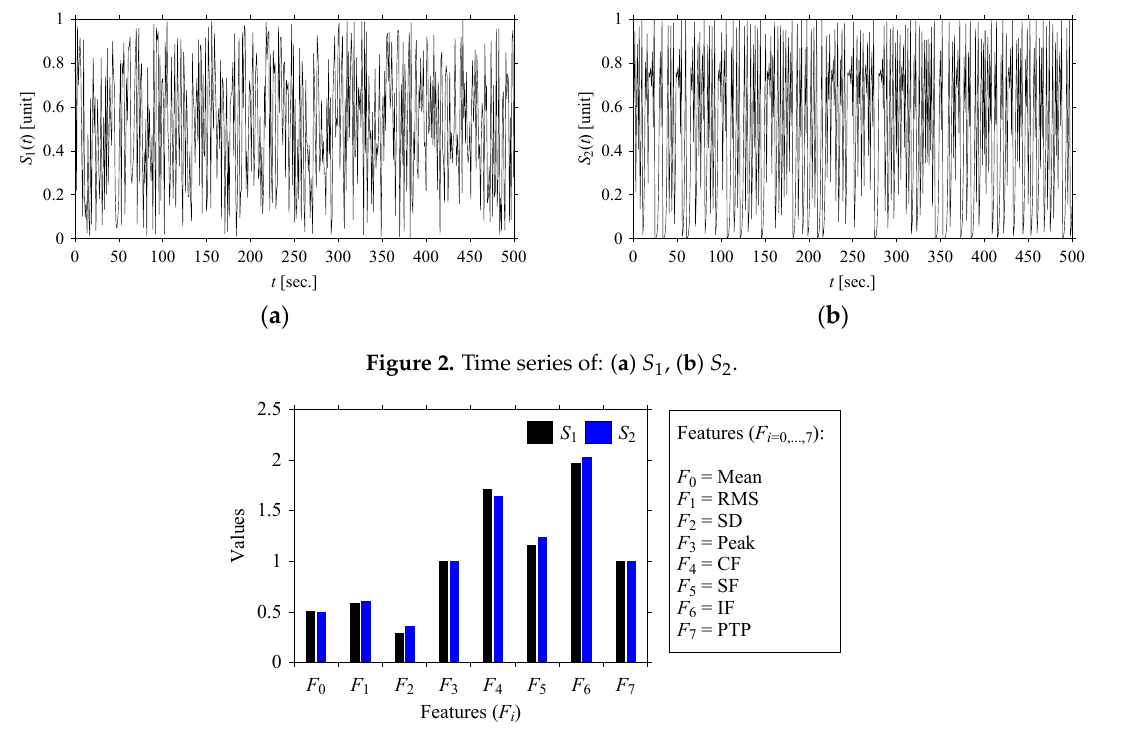
Figure 3. Quantifying S 1 and S 2 in the time domain.